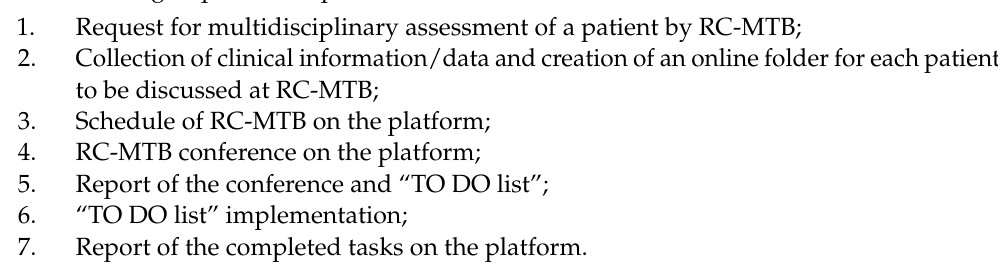
Table 2. Activity flow for the IT platform